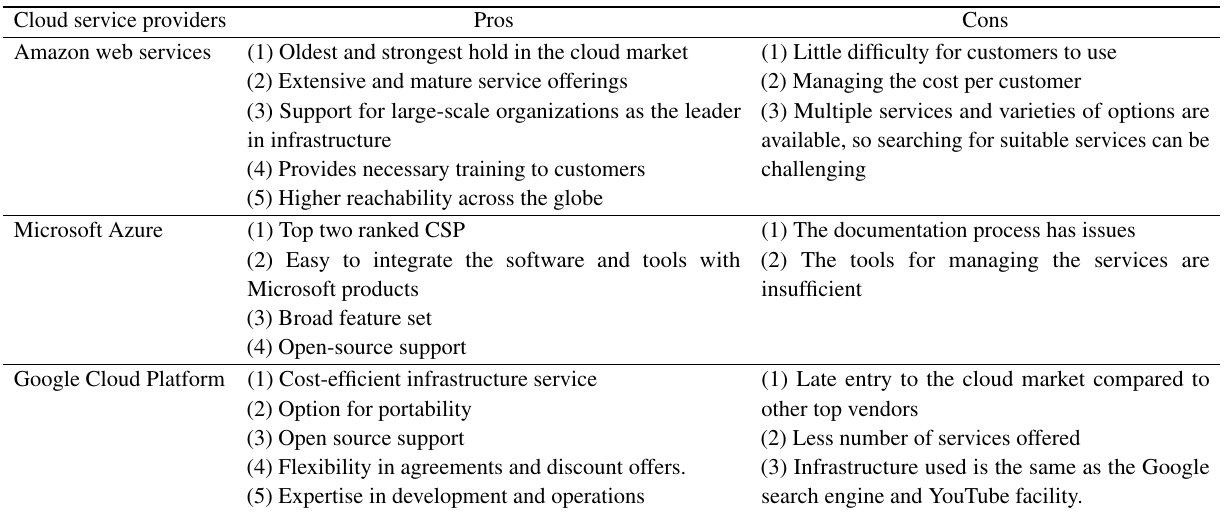
Table 9 Pros and cons of top three cloud